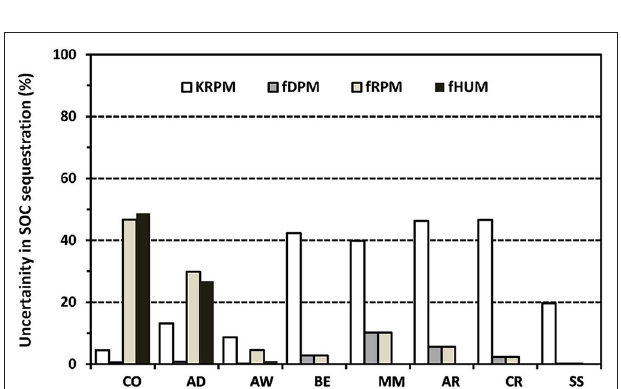
FIGURE 9 | Uncertainty in soil C sequestration introduced by the different EOM pool parameters describing EOM quality. CO, compost; BE, bioenergy by-products; AD, anaerobic digestates; MBM, meat and bone meals; AR, animal residues; CR, crop residues; AW, agro-industrial wastes; SW, sewage sludges. The uncertainty introduced by DPM was extremely low ( < 1.1%) and therefore not included in the graph.